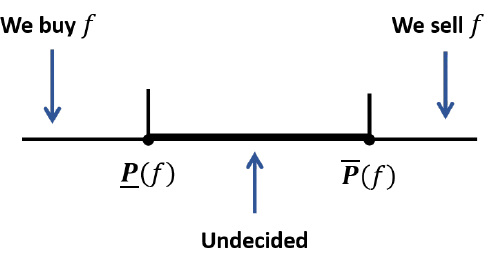
Figure 1. Highest buying price and lowest selling price for a gamble f —imprecise models allow for